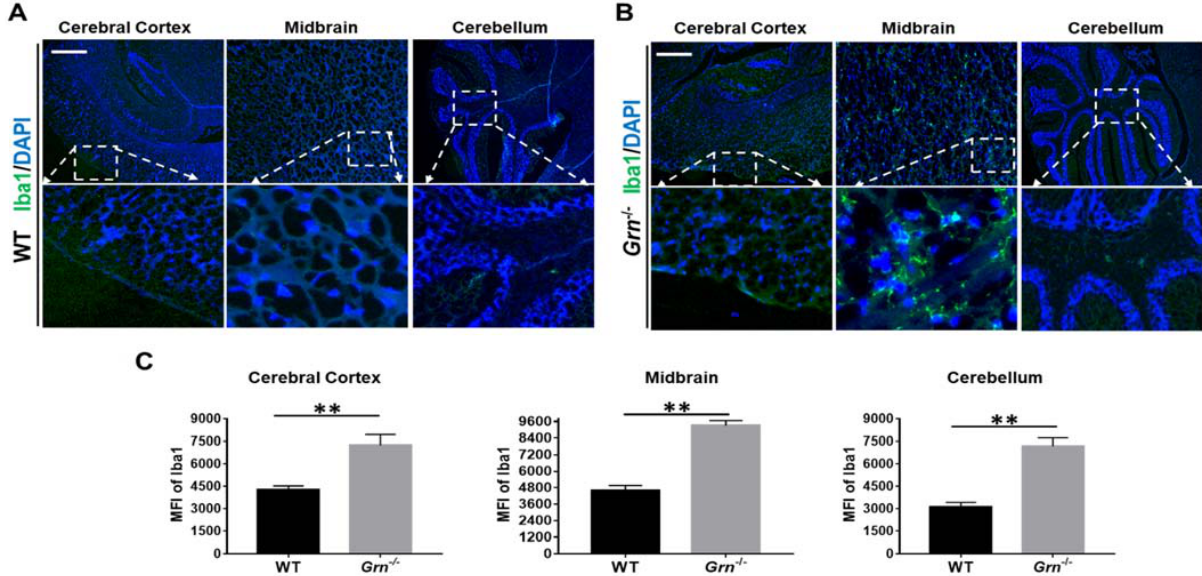
Figure 2. Ablation of PGRN promoted the activation of microglia in aged mice. Brain sections from 12-month-old WT and Grn − /– mice were stained with anti-Iba1 antibody. The accumulation of Iba1-positive cells was analyzed in three different brain regions, cerebral cortex, midbrain, and cerebellum, using immunofluorescence staining. ( A , B ) Representative images of three different brain regions from three independent WT mice or Grn − /– mice. ( C ) Statistical analysis of A and B. Scale bar: 100 µ m. n = 3. Data presented as mean ± SD. ** p < 0.01.